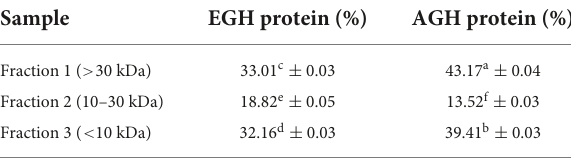
TABLE 2 Protein distribution in hydrolyzed fractions from early grasshopper hydrolysates (EGH) and adult grasshopper hydrolysates